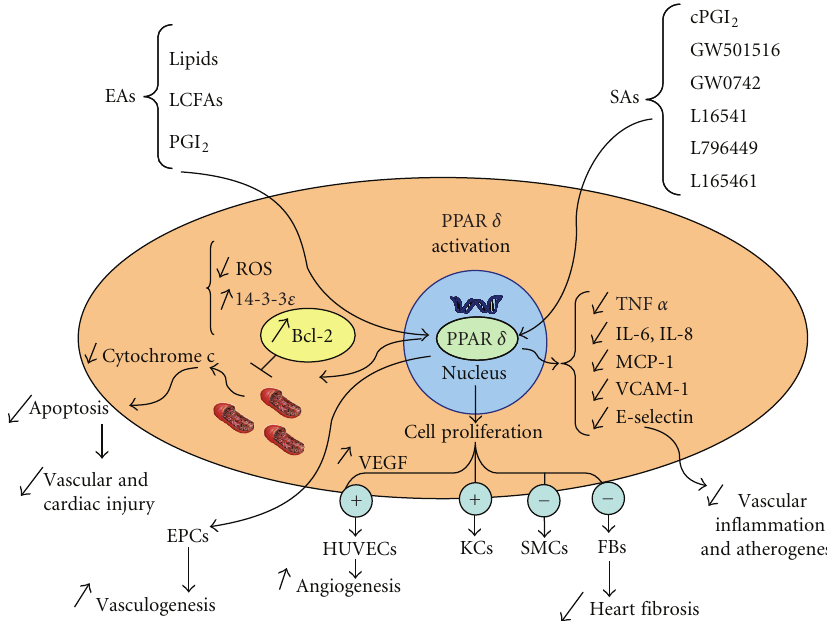
Figure 1: E ff ects of PPAR δ activation on potential targets implicated in cell death, cell proliferation, and inflammation. PPAR δ can be activated not selectively by endogenous agonists (EAs), such as several lipids, long-chain fatty acids (LCFAs), and prostacyclin (PGI 2 ), or synthetic agonists (SAs). PPAR δ activation has an antiapoptotic e ff ect reducing reactive oxygen species (ROS), upregulating 14-3-3 ε activity and reducing cytochrome c release from mitochondria and subsequent caspase-3 activation. The e ff ect of PPAR δ activation on cell proliferation is cell type dependent. It has a proangiogenetic e ff ect in human umbilical endothelial cells (HUVECs), a proproliferative e ff ect in keratinocytes (KCs), while an antiproliferative e ff ect in smooth muscle cells (SMCs) and in cardiac fibroblasts (FBs) with subsequent reduction of heart fibrosis. PPAR δ activation in endothelial progenitor cells (EPCs) enhances vasculogenesis. PPAR δ has anti-inflammatory e ff ects by reducing cytokines production and molecules implicated in endothelial/leukocyte